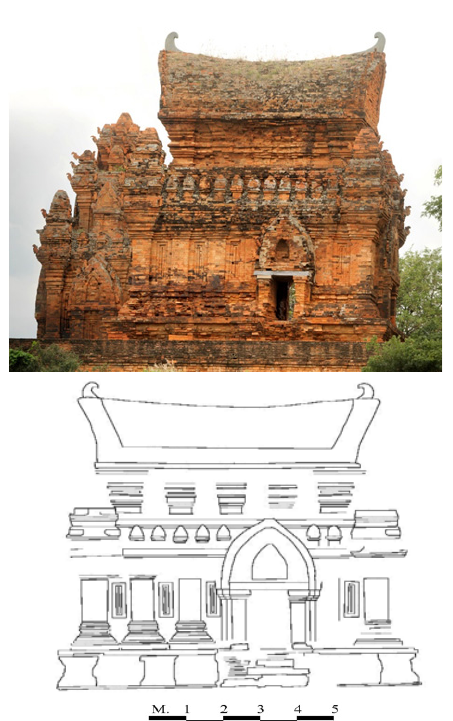
Figure 9. Po Klong Garai tower and line restitution. The long-saddle shaper curved roof is its characteristic